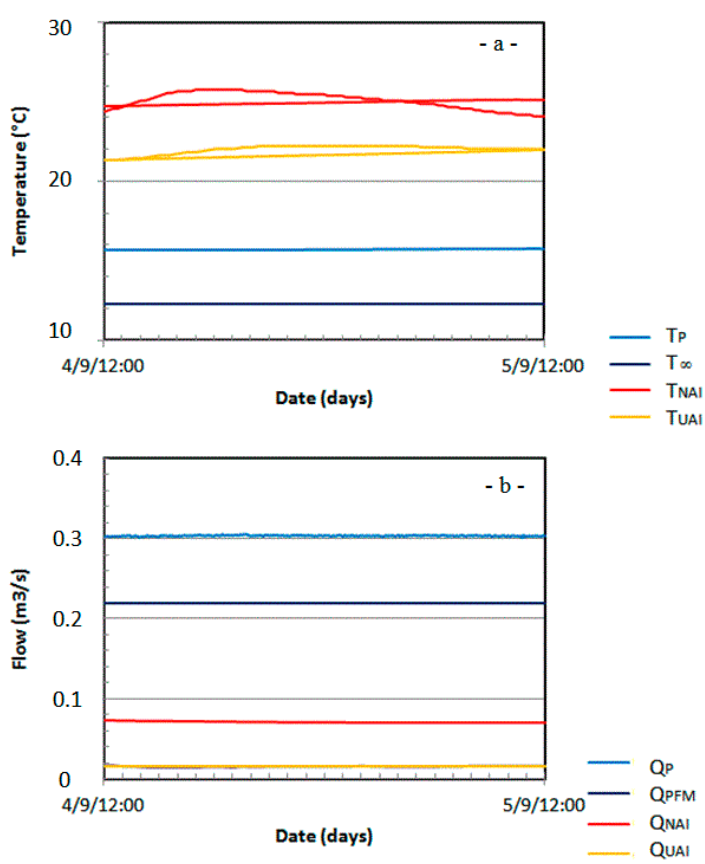
Figure 9. ( a ) Temperatures and ( b ) flows recorded or calculated during the equilibrium-pumping (see Table 1). The conduit system temperature ( T CS ) and the matrix-conduit flow temperature ( T P ) are stable over this period while the Upstream Allogenic Intrusion temperature ( T UAI ) and the Neighbor Allogenic Intrusion temperature ( T NAI ) display sinusoidal diurnal trends that are smoothed by the 24-h moving averaging. Bottom: The Upstream Allogenic Intrusion recharge ( Q UAI ) and the pump discharge ( Q P ) remain almost constant during Period (g). Solving of Equation (16) allows calculating the Neighbor Allogenic Intrusion ( Q NAI ) and the recharge of the Matrix-Conduit flow ( Q PFM ).